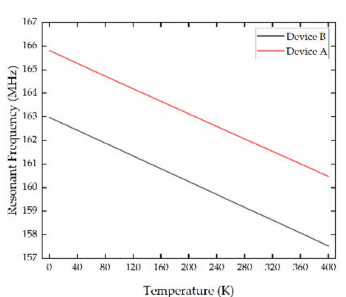
Figure 9. Temperature response of SAW sensors with different electrode